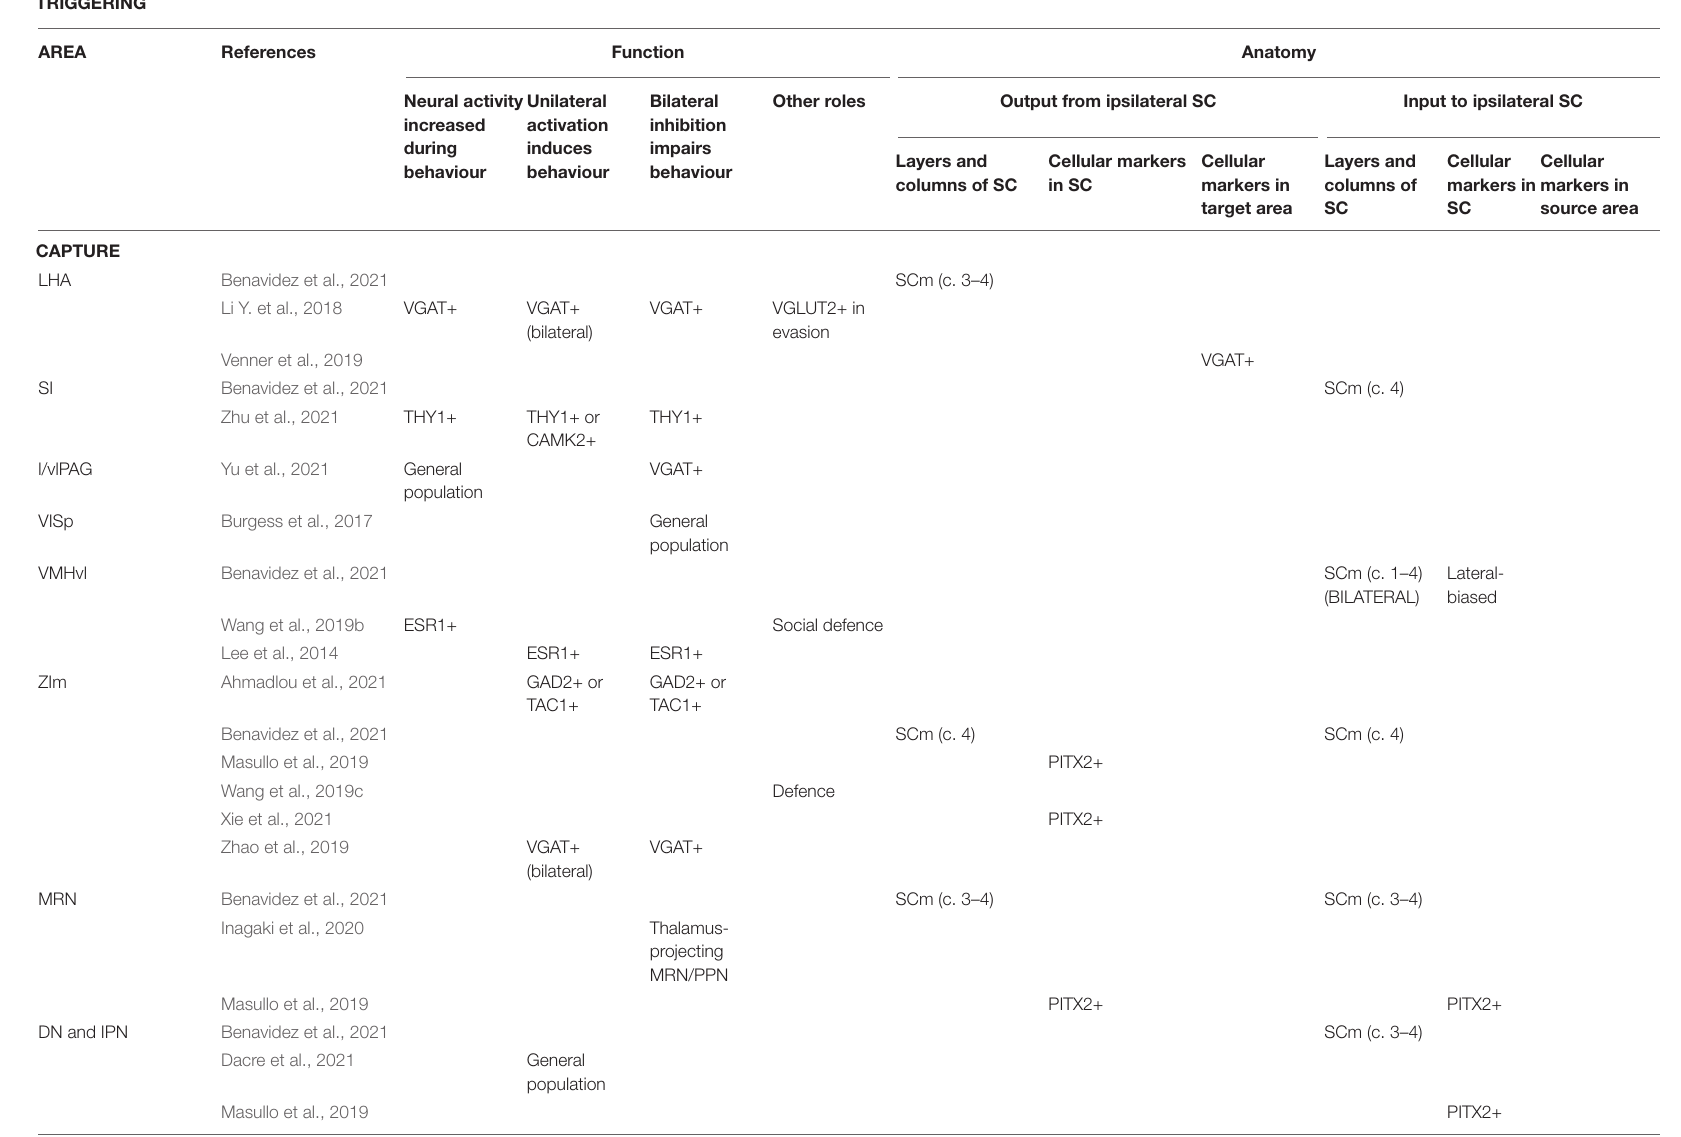
TABLE 4 | Areas reported to be involved in the triggering of capture and